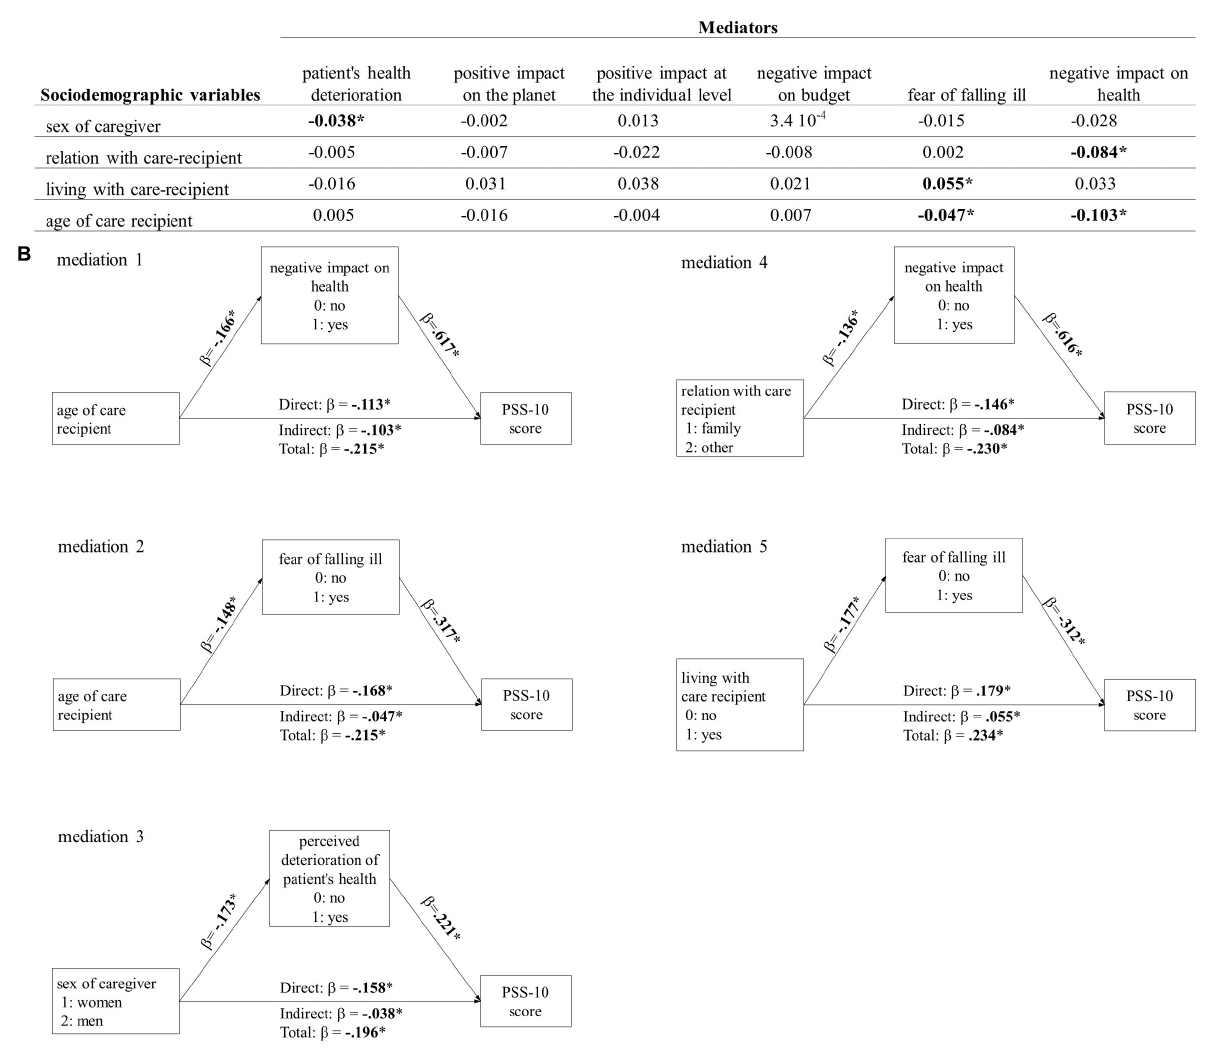
FIGURE 1 | (A) . The standardized effect size ( β ) for indirect mediation of all the mediation models tested. Bold highlights p -value < 0.05. In all cases, direct effects are significant. (B) . Diagram illustrating the significant mediations and reporting the standardized effect size ( β ) of the corresponding effects. * p <